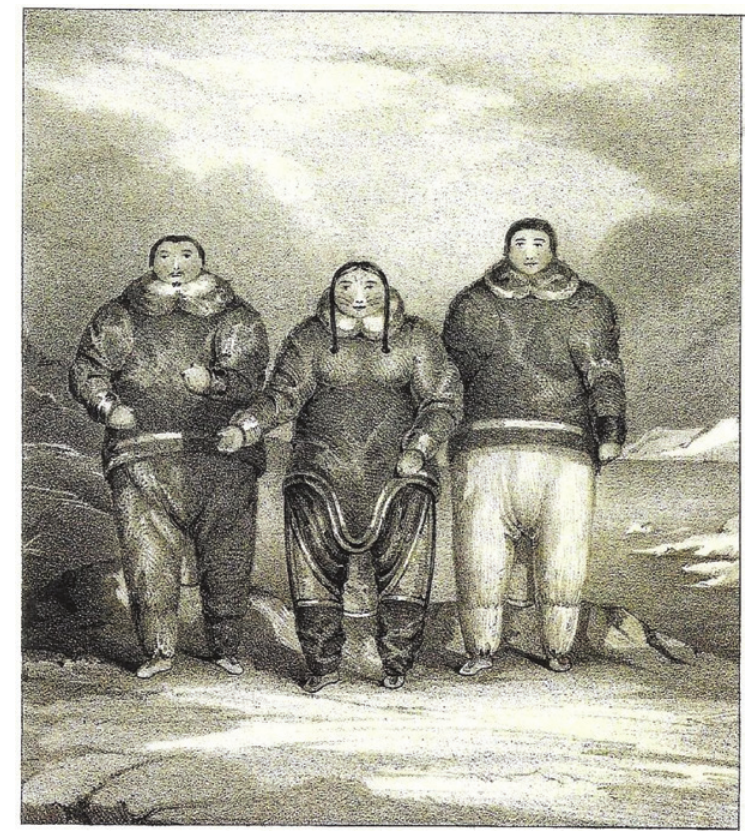
Figure 5. Inuit woman with two men, in deerskin, sealskin and bearskin. Source : Ross, Second Voyage, Appendix 31, 33, 39 and